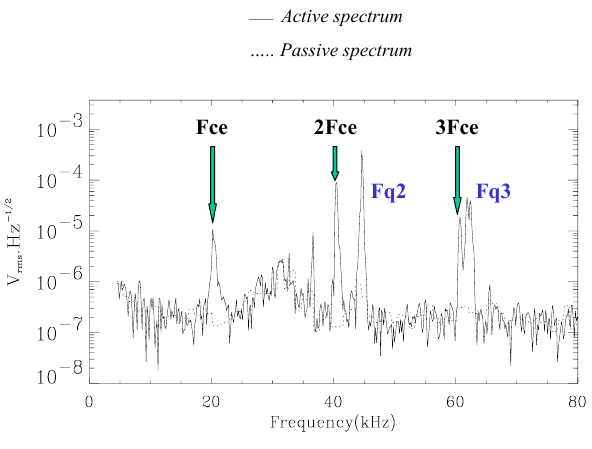
Fig. 3. Individual active spectrum measured in the Earth’s mag- netosphere by Whisper-2. Two monochromatic resonance families are clearly seen: the electron cyclotron frequency, F ce , and two of its harmonics, 2 F ce and 3 F ce , and two double Bernstein’s mode resonances, F q 2 and F q 3 .